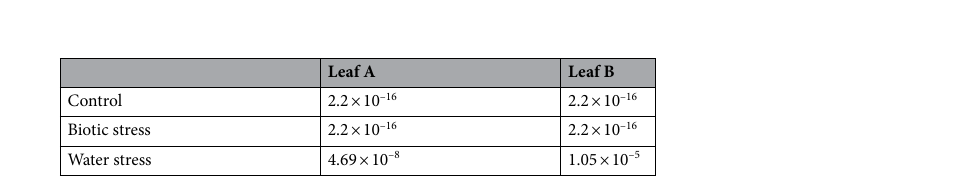
Table 9. p-values of Shapiro–Wilk’s normality test. If p-value is less than 0.05. the null-hypothesis that the data are normally distributed can be rejected.